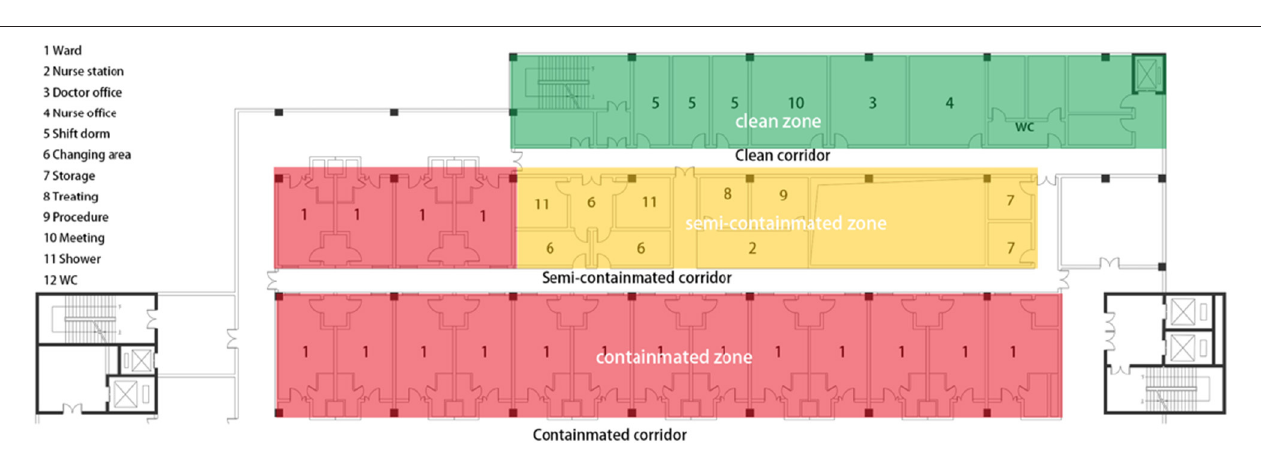
FIGURE 4 | Plan of IDNU in the Shezhen 3rd People Hospital.